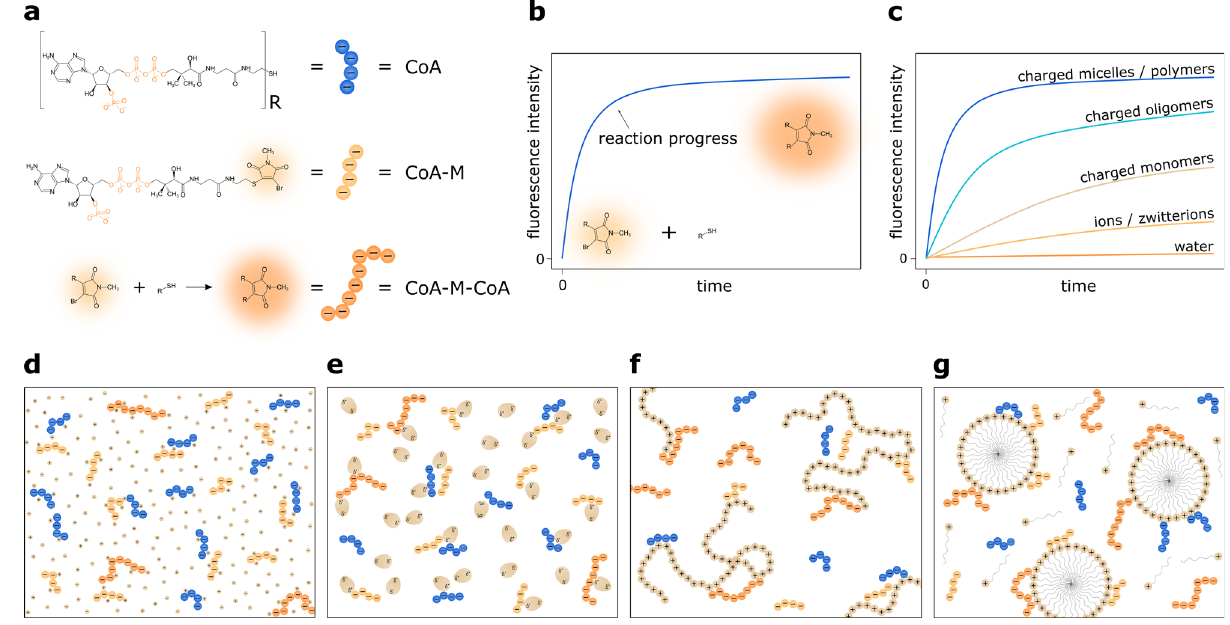
Fig. 1 | Schematic representation of the experimental system. a The reaction betweennegativelychargedcoenzymesA(CoA)isusedasamodelreaction.Oneof them — CoA-M — has fl uorescent moiety. The reaction between reactants occurs through the substitution of bromine in the CoA-M by the thiol group of CoA. This process is practically irreversible, and as a product, CoA-M-CoA molecule is formed. b The product formation is accompanied by an increase in fl uorescence